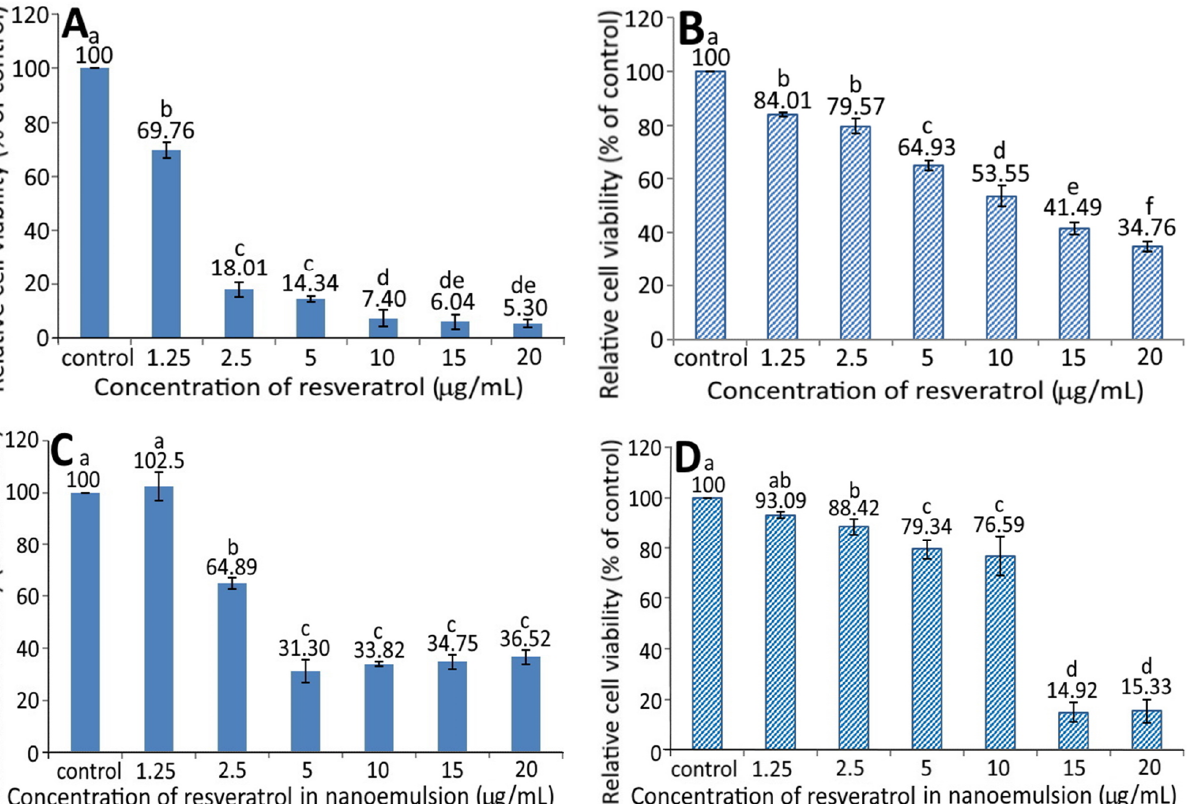
Figure 5. Effect of different concentrations of resveratrol standard ( A , B ) and resveratrol nanoemulsion ( C , D ) on the growth of pancreatic normal cells MS1 ( A , C ) and pancreatic cancer cells BxPC-3 ( B , D ) after 48 h incubation as measured by MTT assay. Control represents that cells were incubated in RPMI medium only. Data are shown as mean ± standard deviation ( n = 3) and data with different small letters (a–f) are significantly different at p <